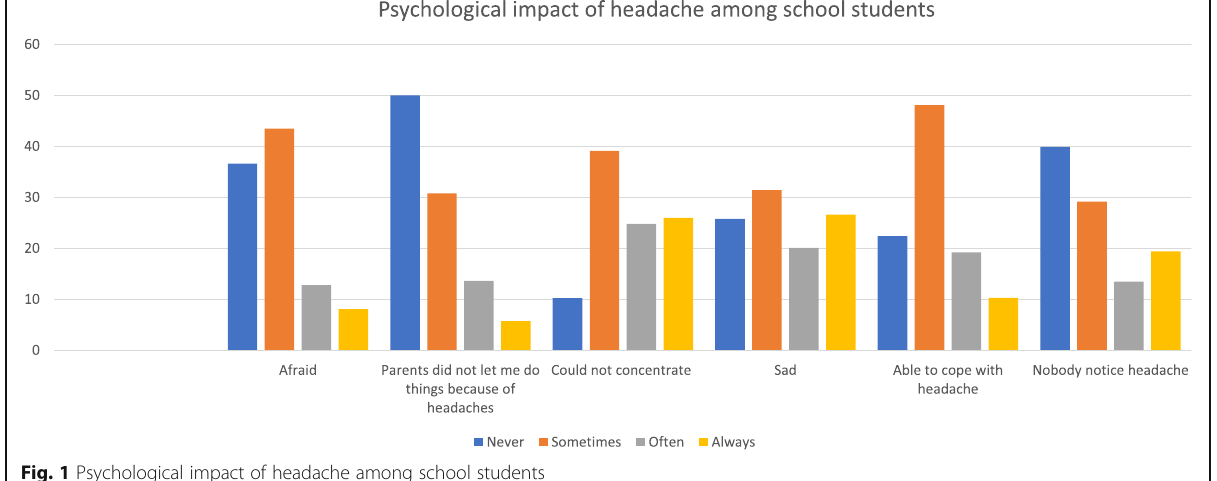
Fig. 1 Psychological impact of headache among school students